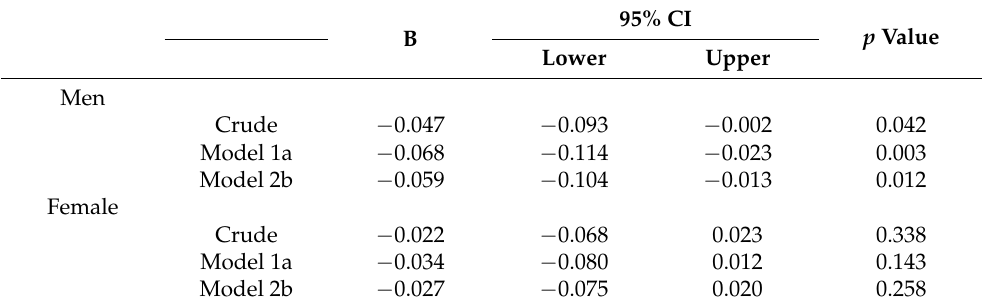
Table 3. Linear regression analysis between frailty score and dietary variety score during one-year follow-up of non-frail subject at baseline.